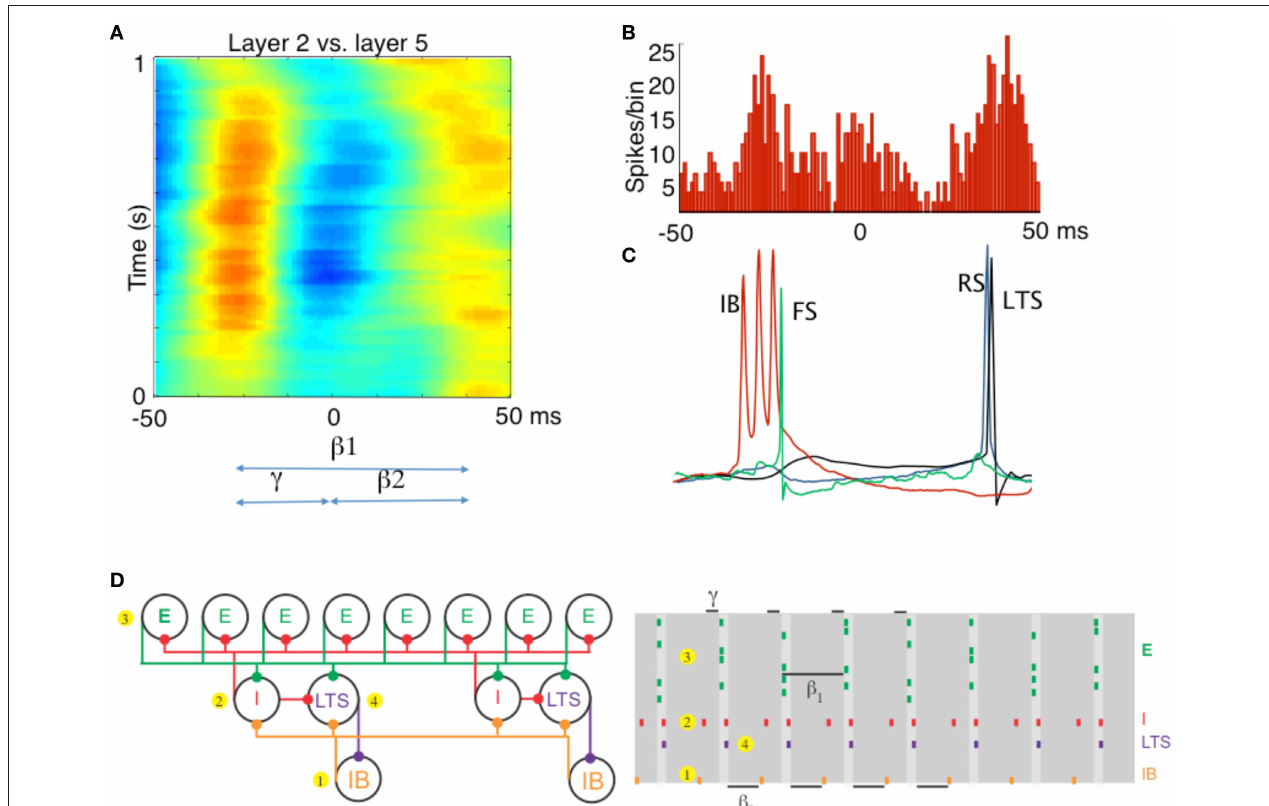
Figure 2 | Different rhythms allow period concatenation. (A) Cross- correlogram showing stable phase relationship between layer 2/3 and layer 5 field potentials in association cortex (S2). When excitation is high, layer 2/3 generates a gamma rhythm (c. 40 Hz) and layer 5 a beta2 rhythm (c. 25 Hz). Reducing excitation then concatenates these two rhythms to generate a beta1 (c. 15 Hz) frequency oscillation in both layers. (B) The asymmetric phase relationship seen for field potentials in (A) is also seen when comparing the timing of layer 2 units with layer 5 units. (C) Intracellular recordings, relative to an on-going beta1 frequency field potential, show the sequence of outputs from different neurons. Each beta1 period begins with a brief burst from layer 5 intrinsically bursting (IB) neurons. This triggers single spikes in superficial fast spiking interneurons (FS). Superficial regular spiking pyramids (RS) spike on the rebound of the resulting IPSP, triggering superficial low-threshold spiking